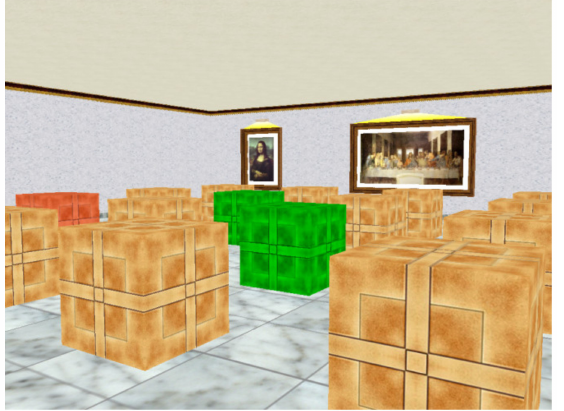
Figure 1. View of the